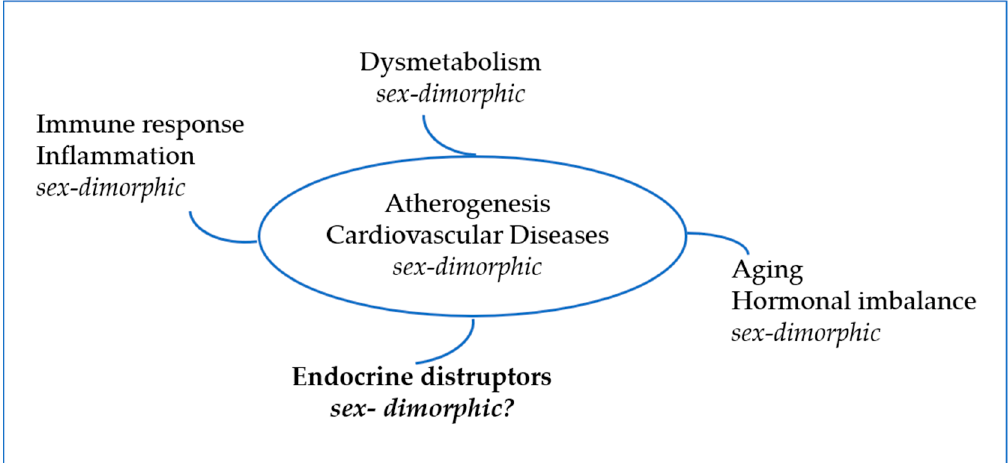
Figure 2. Risk factors for CVD. As the main risk factors related to CVD development exhibit sex- dimorphism, sex-dependent effects of Eds are conceivable as well.